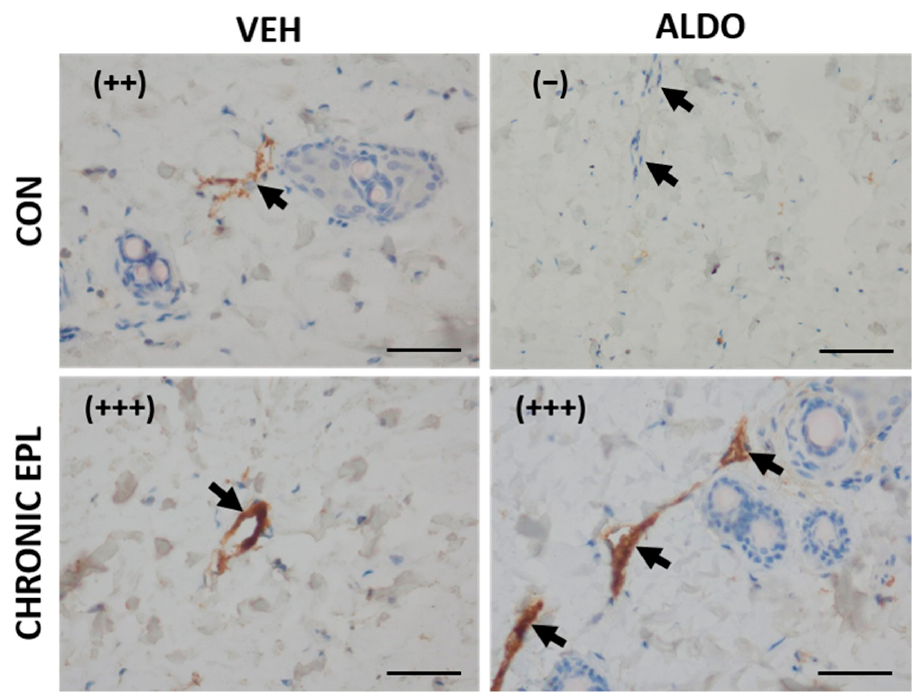
Figure 6. Chronic EPL administration led to vWF accumulation in the blood vessels. n = 8; n for each group is the number of skin samples, not the number of animals; 32 rats were used in this experiment; immunohistochemical staining for von Willebrand factor showed a lack of staining ( − ) in ALDO-injected skin. Chronic EPL administration increased staining strength (+++) and prevented the ALDO effect. ALDO—aldosterone; CON—5% gum arabic solution; EPL—eplerenone; VEH—ALDO solvent. ( − )—lack of staining; (++)—moderate staining; (+++)—strong staining. Arrows point to blood vessels. Scale bars: 50 μ m.